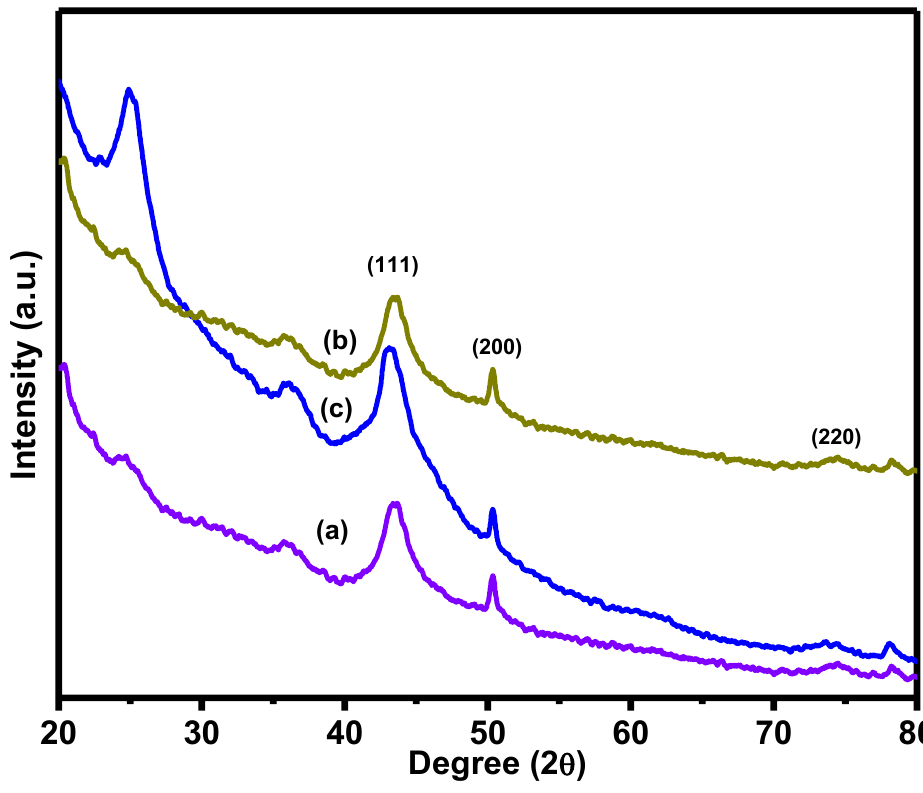
Figure 1. XRD spectra of ( a ) 1Cu(0)-AAPTMS@RGO-MCM-41, ( b ) 5Cu(0)-AAPTMS@RGO-MCM-41, and ( c ) 10Cu(0)-AAPTMS@RGO-MCM-41 samples. The Raman spectra of (a) 1Cu(0)-AAPTMS@RGO-MCM-41, (b) 5Cu(0)-AAPTMS@RGO- MCM-41, and (c) 10Cu(0)-AAPTMS@RGO-MCM-41 are represented in Figure 2. In these spectra, all the composite materials give the characteristic D and G bands. The bands at 1355 cm − 1 represent the disorder in the sp 2 -hybridized carbon atoms, and 1604 cm − 1 represents σ -sp 2 bonded C-atoms in carbon-based graphene materials. The D and G band position slightly shifted towards the higher wavenumber for all the samples. The shift was due to metal modification via molecular interaction. The Id/Ig ratios were 0.69, 0.73, and 0.72 for (a) 1Cu(0)-AAPTMS@RGO-MCM-41, (b) 5Cu(0)-AAPTMS@RGO- MCM-41, and (c) 10Cu(0)-AAPTMS@RGO-MCM-41 samples. The Id/Ig ratio of metal-modified functionalized composite materials increased the intensity of the Id/Ig ratio up to 0.1 compared with graphene oxide.